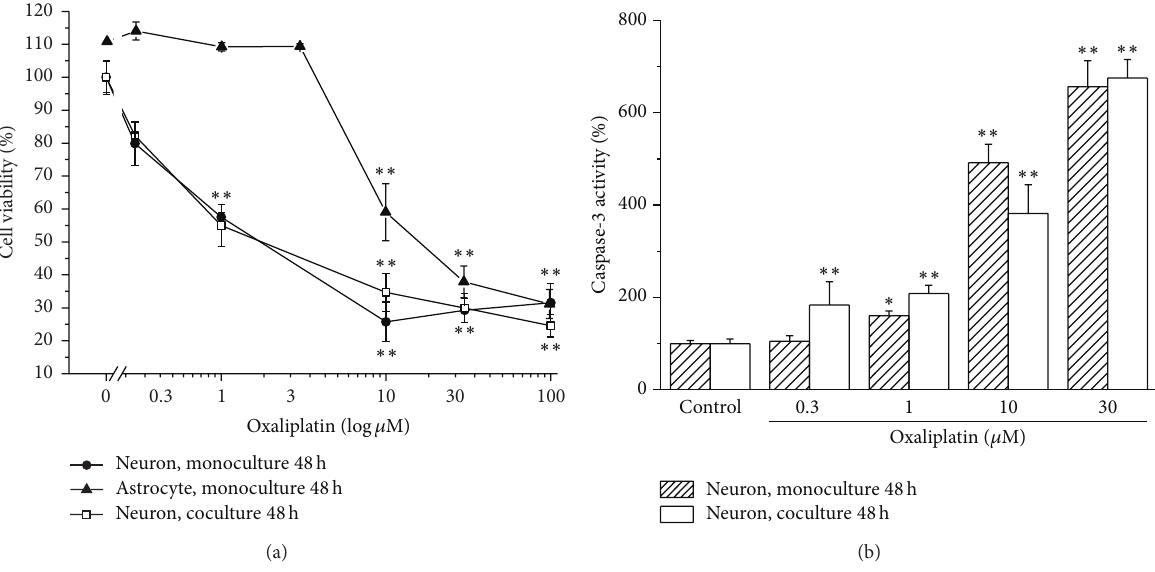
Figure 1: Oxaliplatin toxicity in mono- and cocultures. (a) Cell viability. Neuron monoculture (10 4 cells/well), astrocyte monoculture (10 4